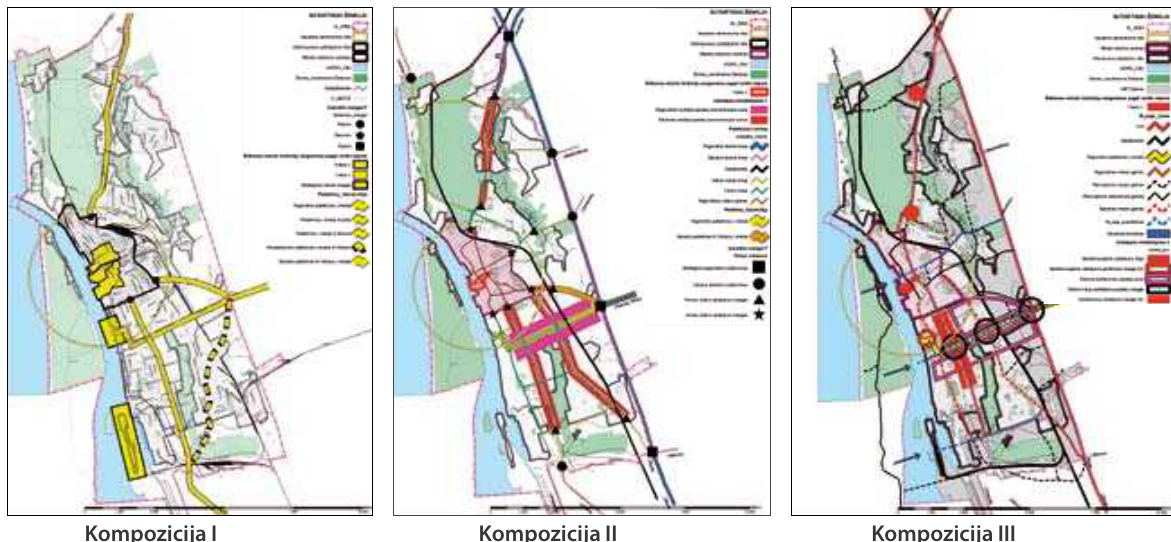
Fig. 10. Perspective models of the city compositional framework with different development of high-rise building on a city scale